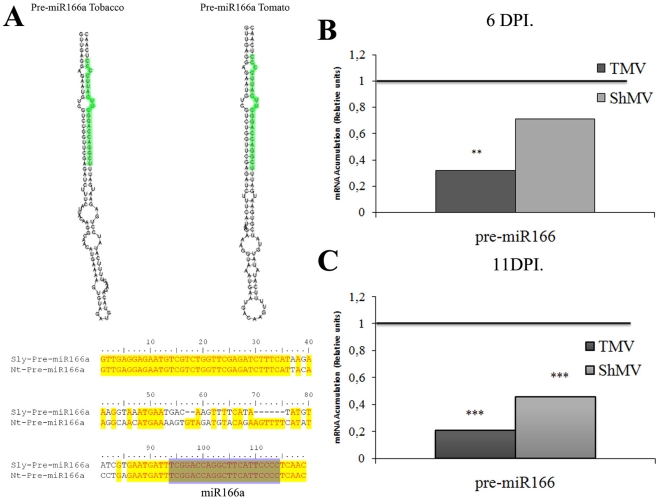
Pre-miRNA166 is reduced after virus infection.
A) Predicted fold-back secondary structures of tobacco and tomato miRNA166a precursors as determined by the RNAfold program. Mature miRNA sequences are highlighted in green. Clustal alignment between Pre-miRNA166a sequences from tobacco and tomato. (BC) Pre-miRNA166a qPCR quantification in plants infected with TMV or ShMV, (B) 6 dpi and (C) 11 dpi. ** means p-value<0,05 and *** means p-value<0,01.